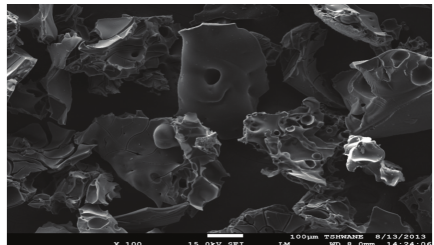
Figure 19: SEM micrograph of char from neat epoxy resin after the Cone Calorimeter thermal analysis.